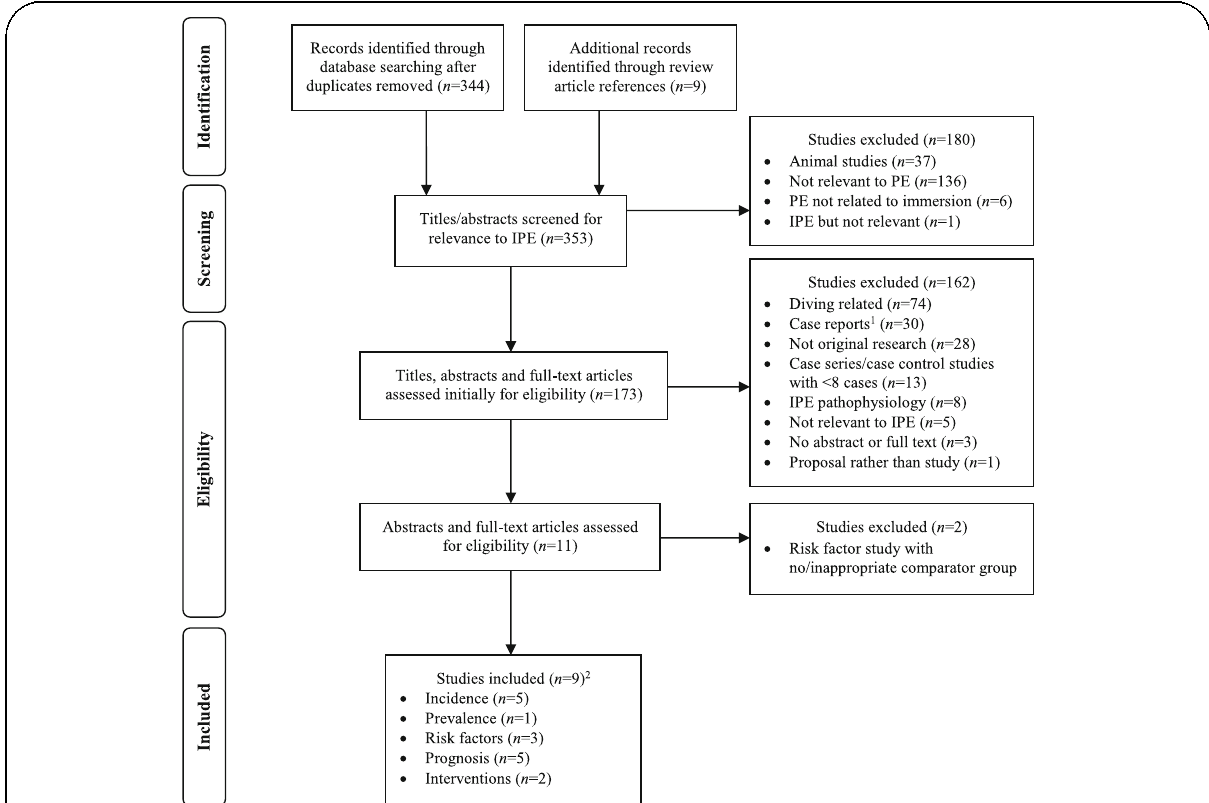
Fig. 1 PRISMA flow diagram. PRISMA Preferred Reporting Items for Systematic Reviews and Meta-Analyses. IPE: immersion pulmonary oedema; PE: pulmonary oedema. 1 One case report was included in the interventions section due to a lack of relevant studies. 2 Numbers do not add up to total due to studies that addressed more than one research